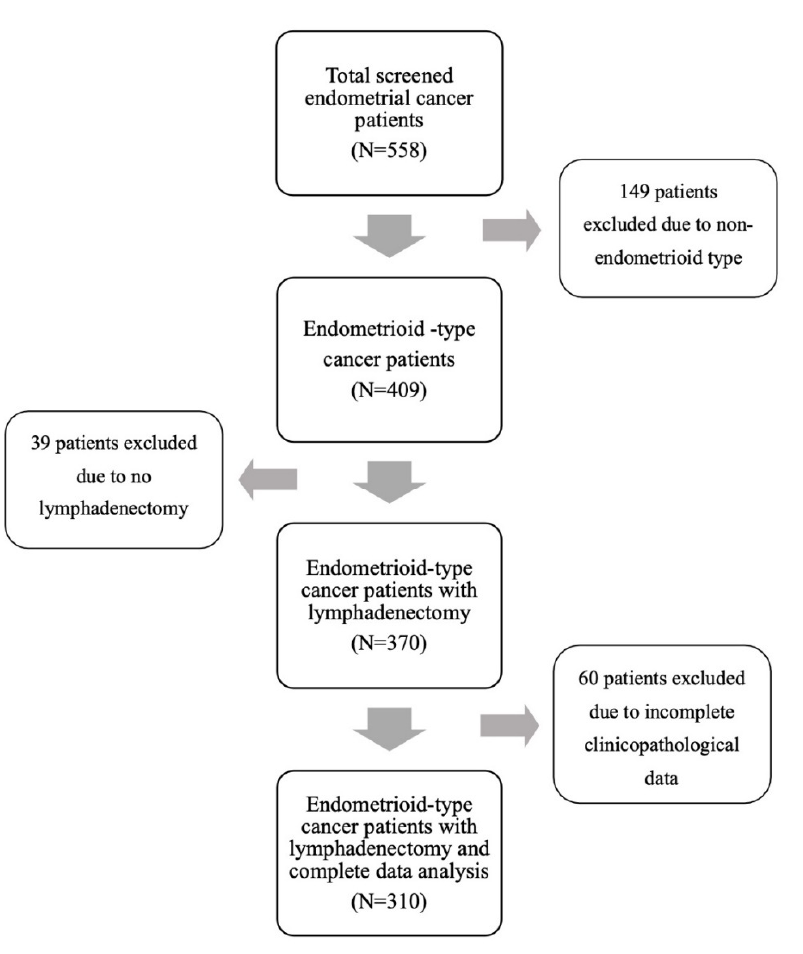
Figure 1. CONSORT flow diagram of study population.